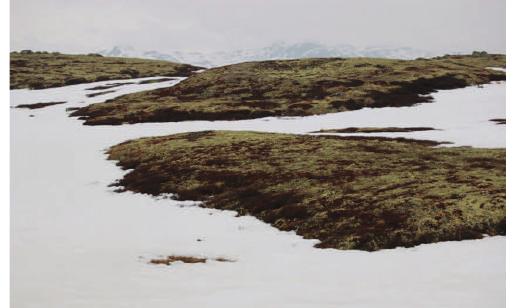
Figure 5. Exposed alpine lichen heaths have often no or a thin snow cover during the winter and are therefore available for reindeer grazing. These areas are most distinctly separated from areas (vegetation types) with a thicker snow layer that has not melted during late winter-early spring. The exposed vegeta- tion on the picture belongs to Type C in Table 3.